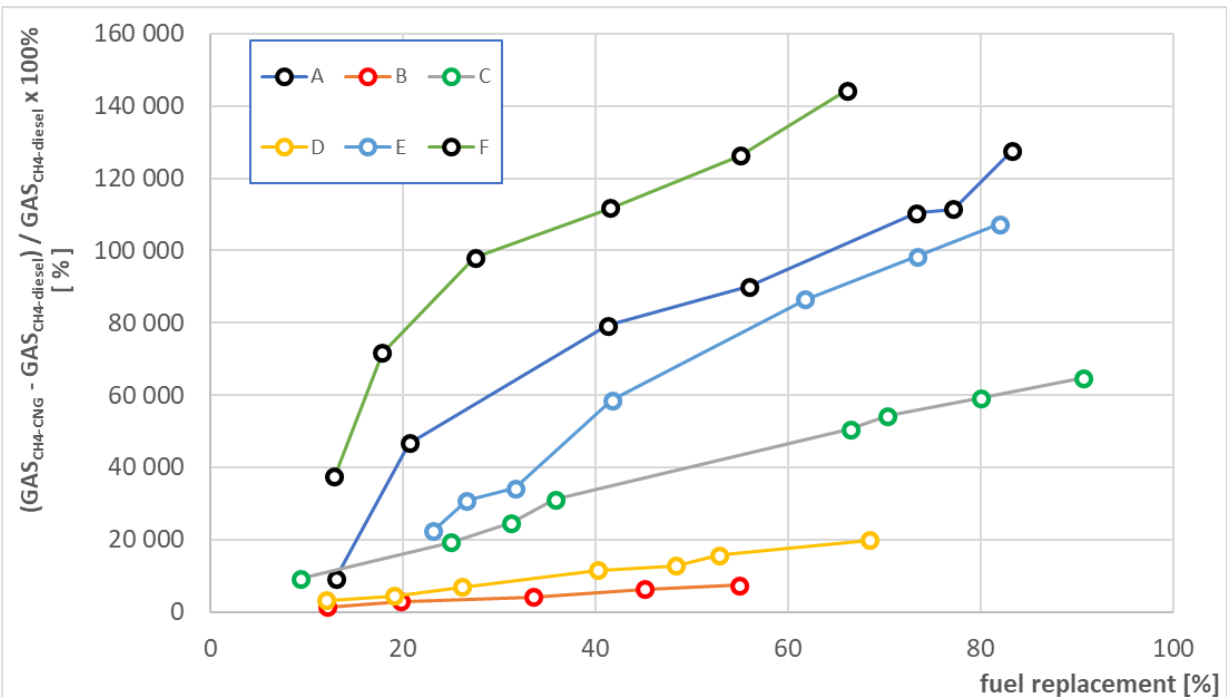
Figure 12. Curves from A to F showing the changes in the emission of methane as the comparison of exhaust gas temperature noted only in single fuel (diesel) working mode for individual engine operating points, where the rotation speed, power, and torque were constant, as a dual-fuel mode (where engine uses CNG and diesel fuel) replacement function.